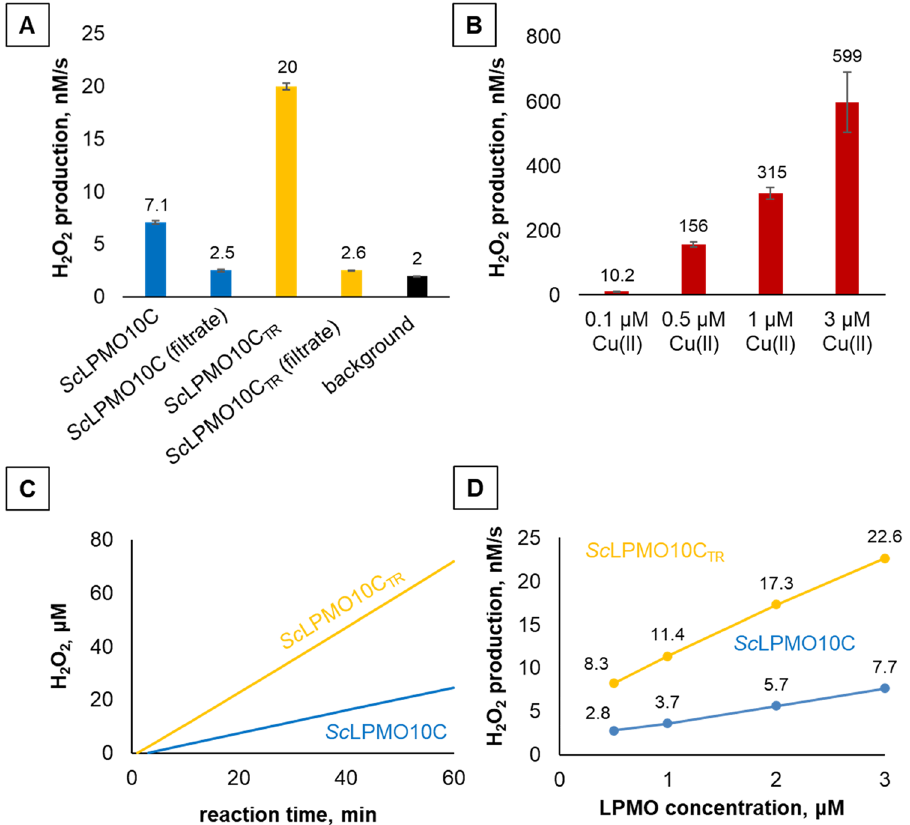
Figure 2. Apparent hydrogen peroxide production in reactions containing Sc LPMO10C and Sc LPMO10C TR (panels A , C , D ) or Cu(II)SO 4 (panel B ) . All experiments were carried out using 1 mM ascorbic acid in 50 mM sodium phosphate buffer, pH 6.0, at 30 °C. Reaction mixtures contained 5 U/ml HRP, 100 µM Amplex Red, 1% (v/v) DMSO and varying concentrations of LPMOs and Cu(II)SO 4 . The data shown in panels A and C are for LPMO concentrations of 3 μM. H 2 O 2 production rates were derived from linear progress curves (such as shown in panel C; in this experiment the signal is monitored continuously). Free copper control experiments designated as “ Sc LPMO10C filtrate” and “ Sc LPMO10C TR filtrate” in panel A were carried our using protein-free samples obtained from enzyme stock solutions by ultrafiltration. Such filtrates will contain the same amount of free copper ions as the LPMO preparations. The black bar in panel A denotes the background rate of hydrogen peroxide accumulation in the reaction containing reductant but lacking LPMO. Error bars indicate standard deviations between triplicates. The rates shown in panels A and D were obtained in independent experiments. Error bars in panel D are hidden behind the